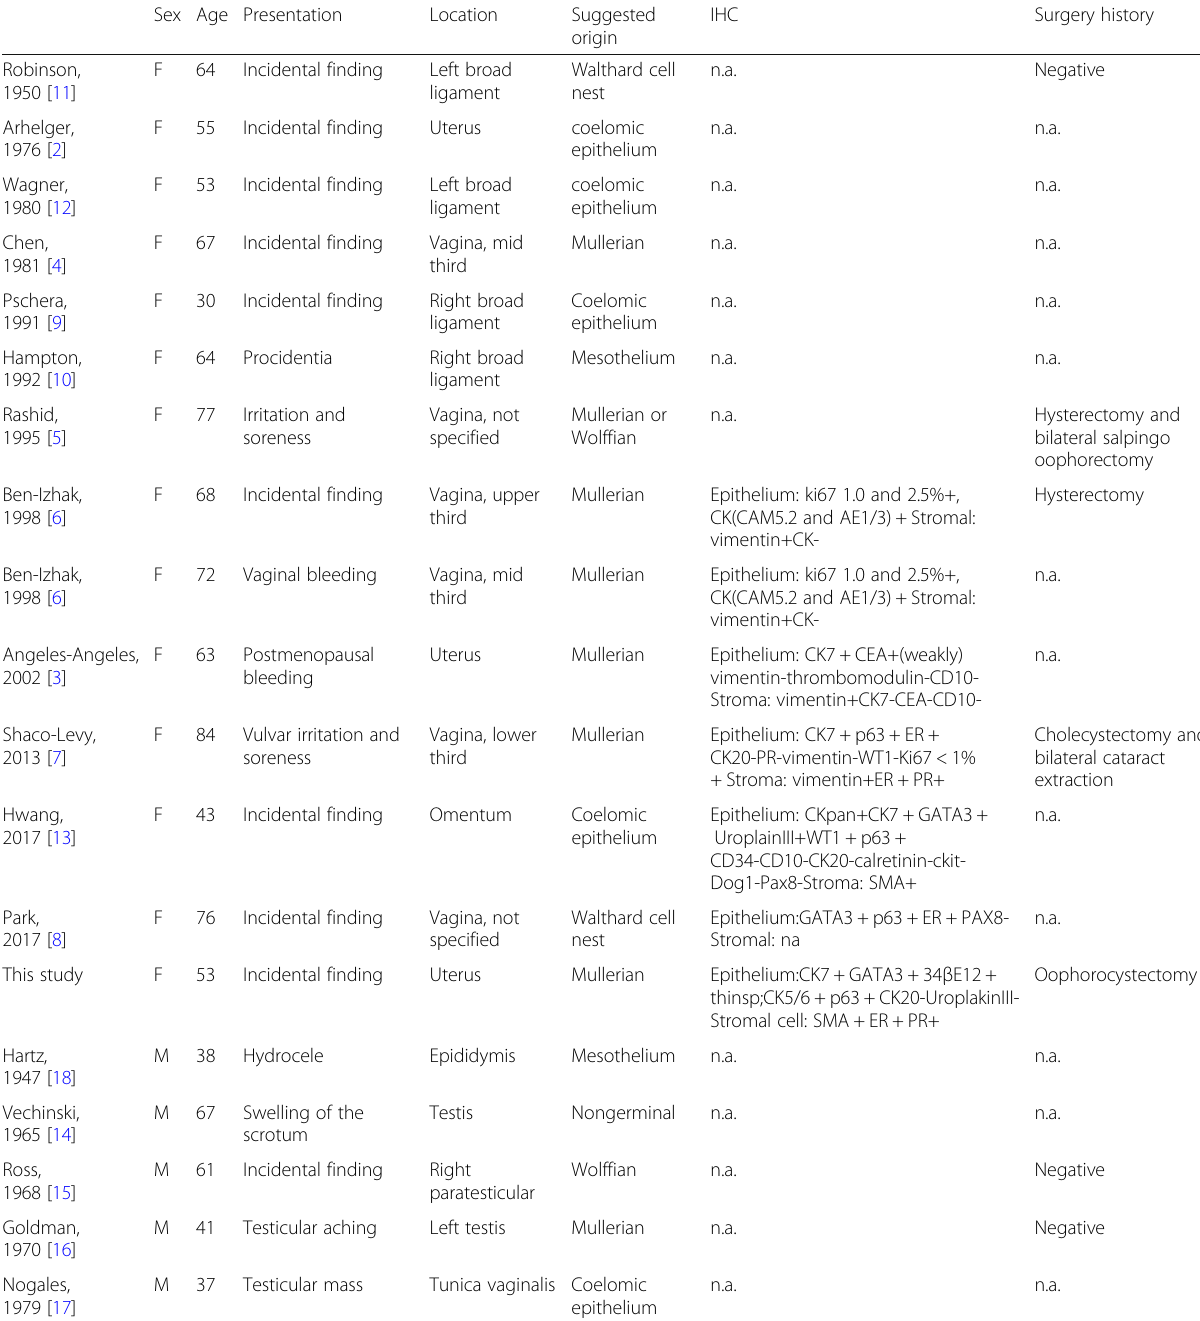
Table 1 Summary of EOBTs Sex Age